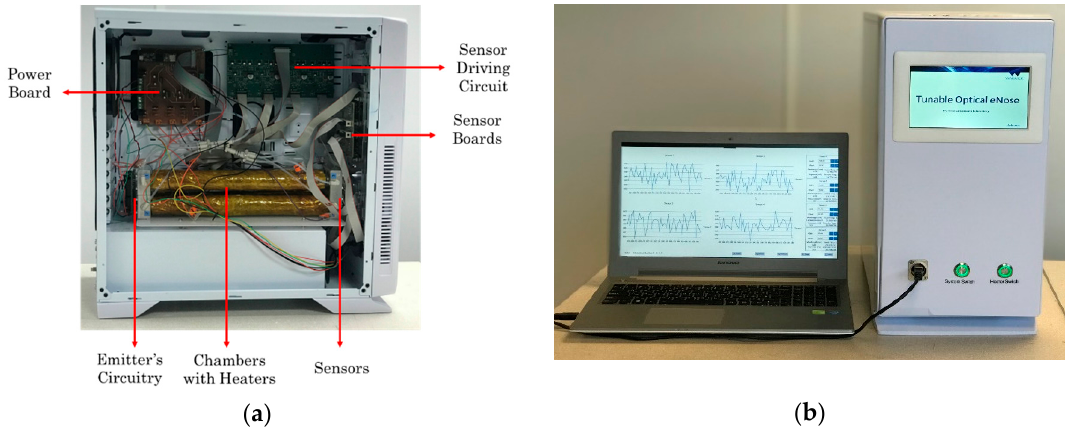
Figure 7. Optical electronic nose: ( a ) internal view; and ( b ) external view, with laptop.